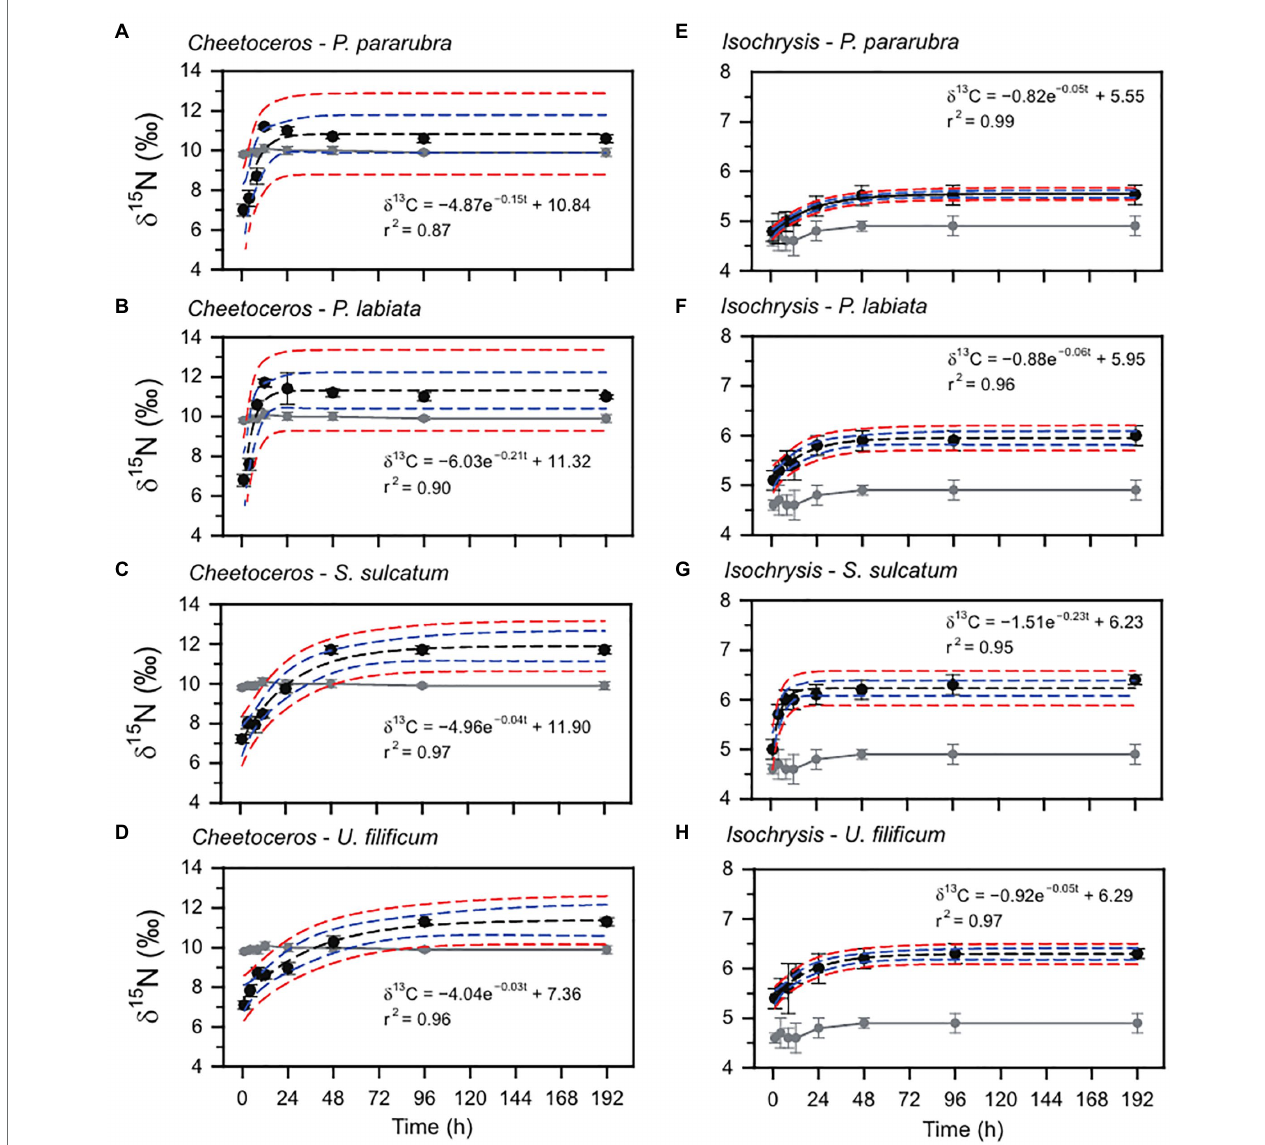
FIGURE 3 | Nitrogen stable isotope variation and exponential model for P. pararubra , Protocruzia labiate , Strombidium sulcatum , and Uronemella filificum fed with Chaetoceros calcitrans (Chaeto) and Isochrysis galbana (Isochrysis). Black and gray circles are the mean of nitrogen stable isotope values ( δ 15 N) for ciliates and foods, respectively. Vertical lines are ± SD . Black and blue dashed lines indicate fitting curve and 95% confidence,